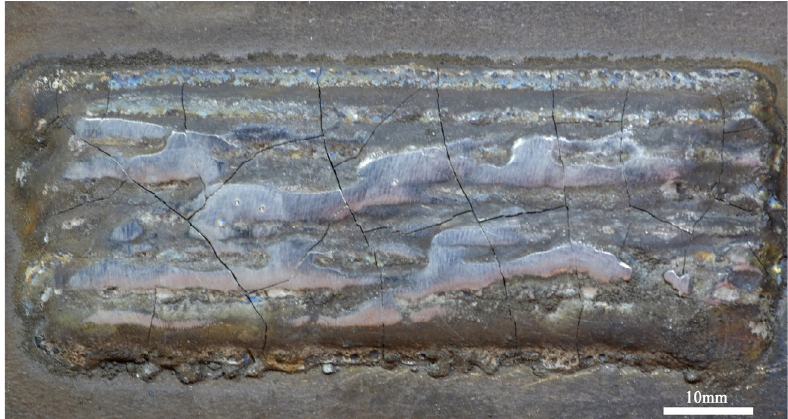
Figure 3. Macroscopic surface morphology of HEA coating with 40% Cr content.